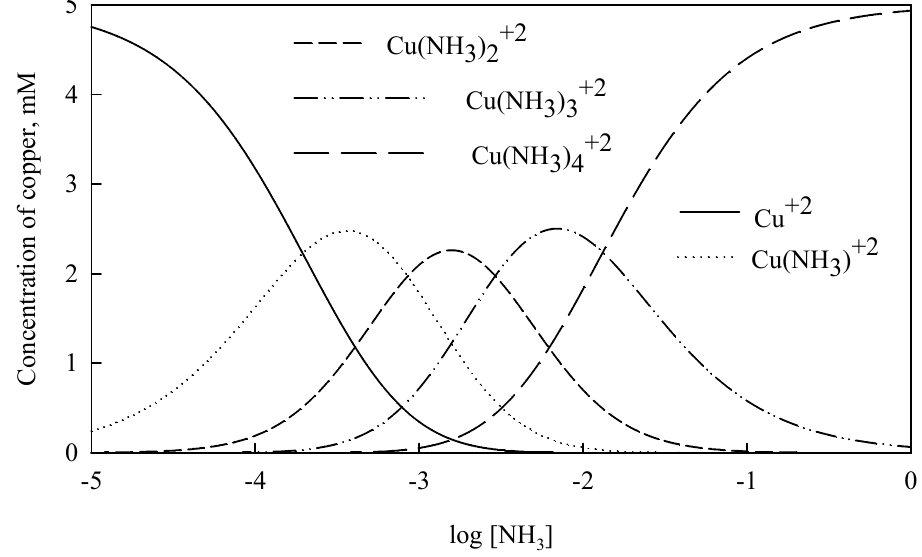
Figure 1. Formation of copper and ammonia complexes based on the concentration of NH 3 .